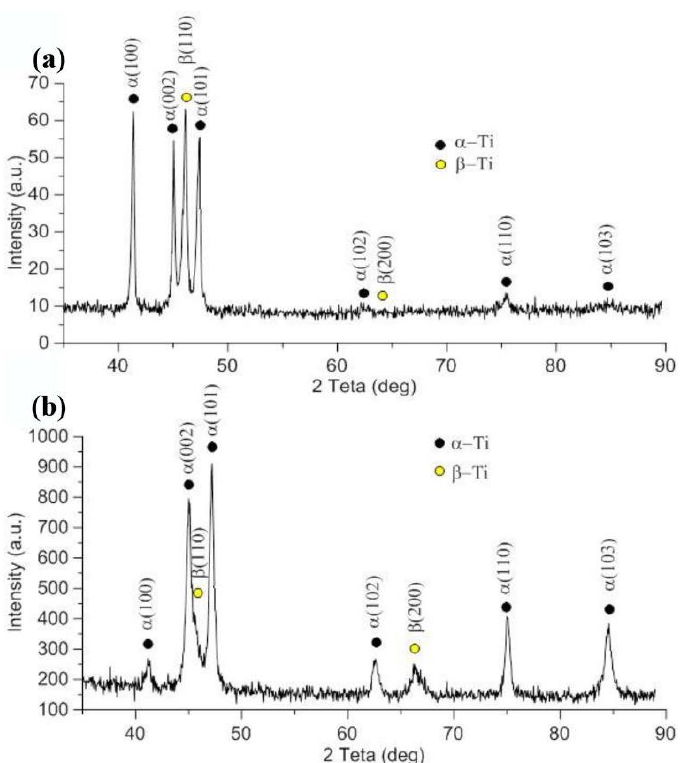
Figure 2. XRD spectra of as-received Ti-6Al-4V ( a ) and Ti-4Al-3Mo-1V alloys ( b ).